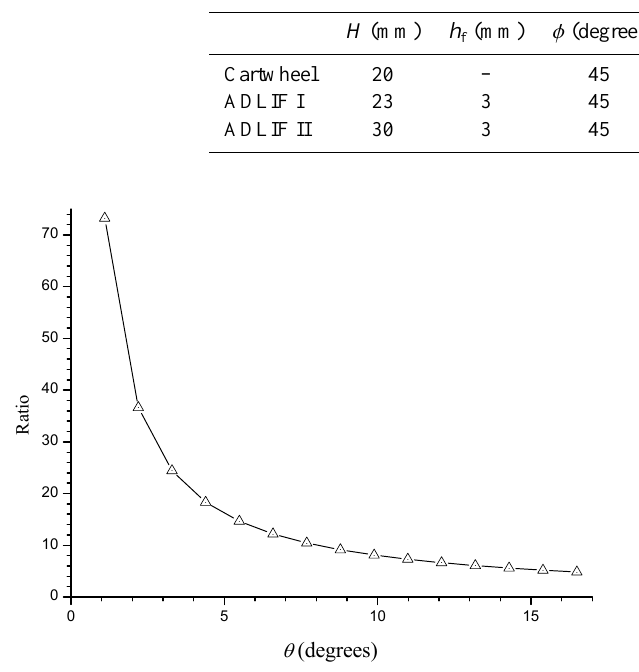
Table 1. Structural parameters of three flexure joints.